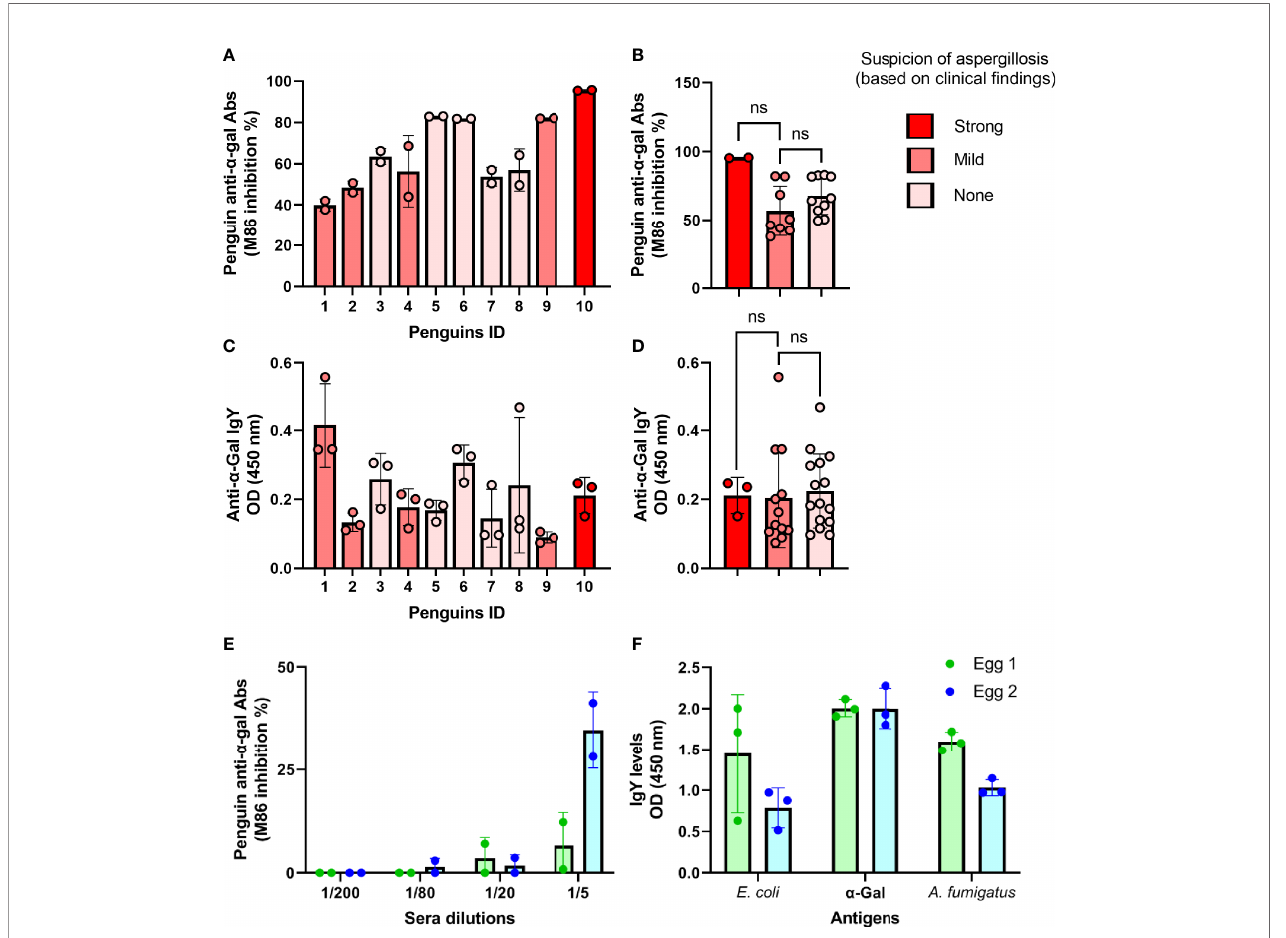
FIGURE 2 | Individual variation of anti- a -Gal Abs in penguin sera and eggs. The levels of circulating total anti- a -Gal Ab (A, B) and anti- a -Gal IgY (C, D) were measured by competitive and indirect ELISA, respectively. Total and IgY anti- a -Gal Abs were variable in the sera of individual penguins (ID 1 - 10). Total anti- a -Gal Ab (C) and anti- a -Gal IgY (D) were measured in two egg yolks by competitive and indirect ELISA, respectively. Egg anti- a -Gal IgY speci fi c to E coli and A. fumigatus proteins were measured by indirect ELISA. M86 binding inhibition % (A, B, E) and OD (C, D, F) means and standard deviation values of technical replicates per sample are displayed. Penguins with strong (Red), mild (rose) or none (light rose) clinical suspicion of aspergillosis were included, as listed in Supplementary Table S1 . Values were compared by unpaired (B, D) student ’ s t -test (ns, not signi fi cant, strong ( n = 1), mild ( n = 4) and none ( n = 5), and three technical replicates per sample).